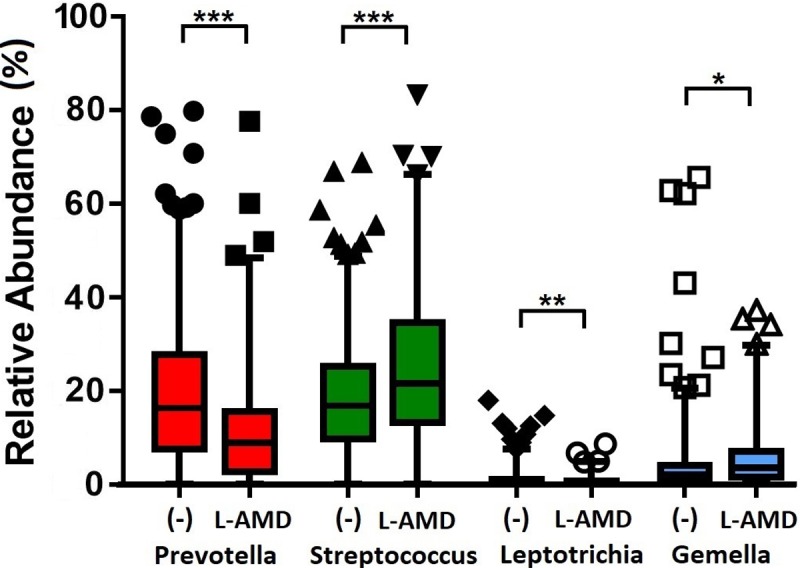
Relative abundances of significant genera between 386 controls and 165 individuals with late AMD.(-) and L-AMD denote controls and late AMD samples respectively. Statistical significance is indicated by (*Adj-p < 0.05), (**Adj-p < 0.005) or (***Adj-p < 0.0005). Mean relative abundances, standard deviations and P-values are presented in S6 Table.